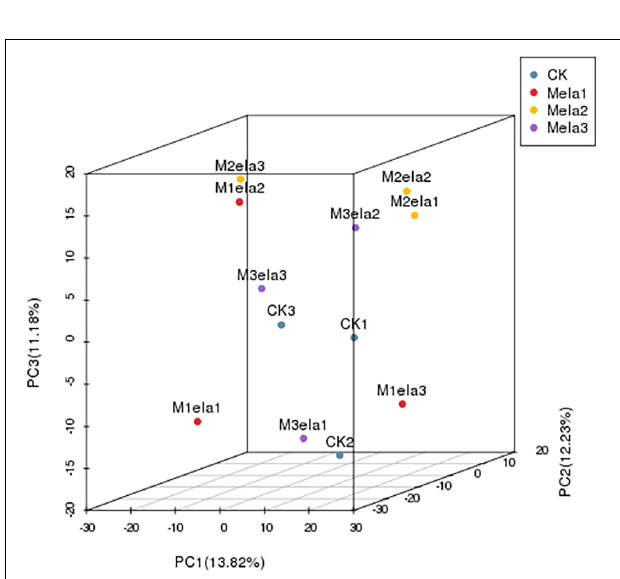
FIGURE 5 | PCA (3D) of metabolic profiles in stylo silage supplemented with melatonin ( n =